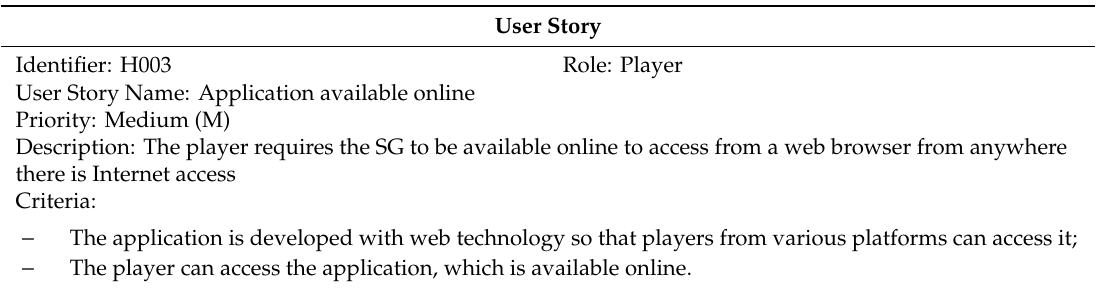
Table 4. User Story